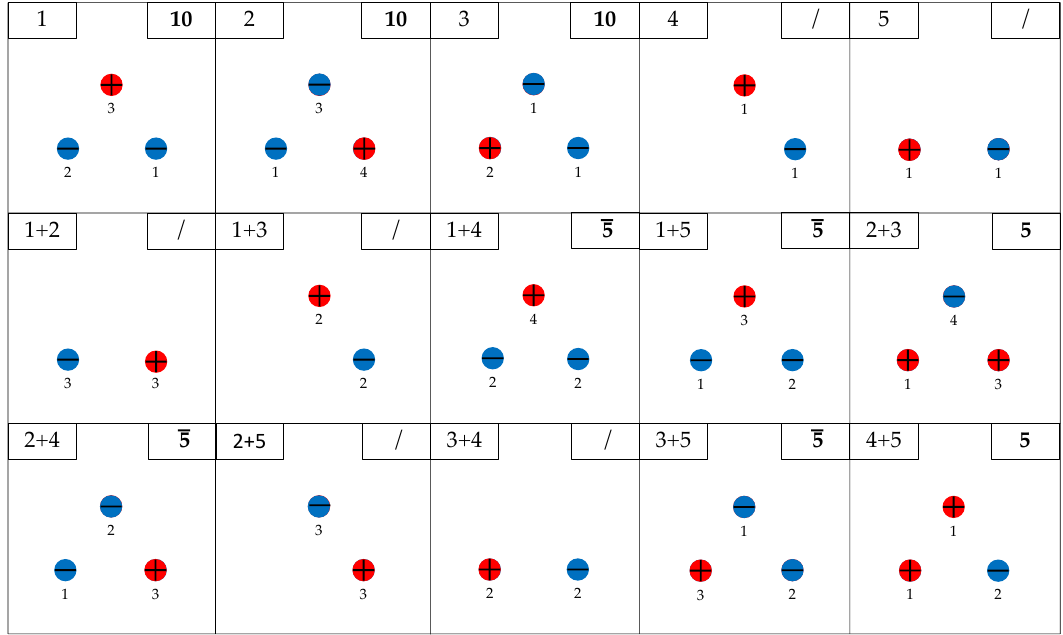
Figure 16 . A charge con(cid:12)guration leading to a chiral spectrum with 3 multiplets transforming in 10 , 4 in 5 and 2 in 5 . There are further multiplets transforming in 1 which are not depicted. Each box shows the same 3 points in M 3 . The (cid:12)rst row shows 5 fundamental charge distributions with the units of charge denoted as subscripts. The total charge of each box vanishes and also adding the (cid:12)rst row of pictures yields a vanishing charge distribution. This re(cid:13)ects (8.21). The bottom two rows show superpositions of the fundamental charge distributions as noted in the top left corner. Each box contributes a single chiral multiplet, denoted in the top right corner of each box, if it depicts 3 charged points. This realizes the matter content as in